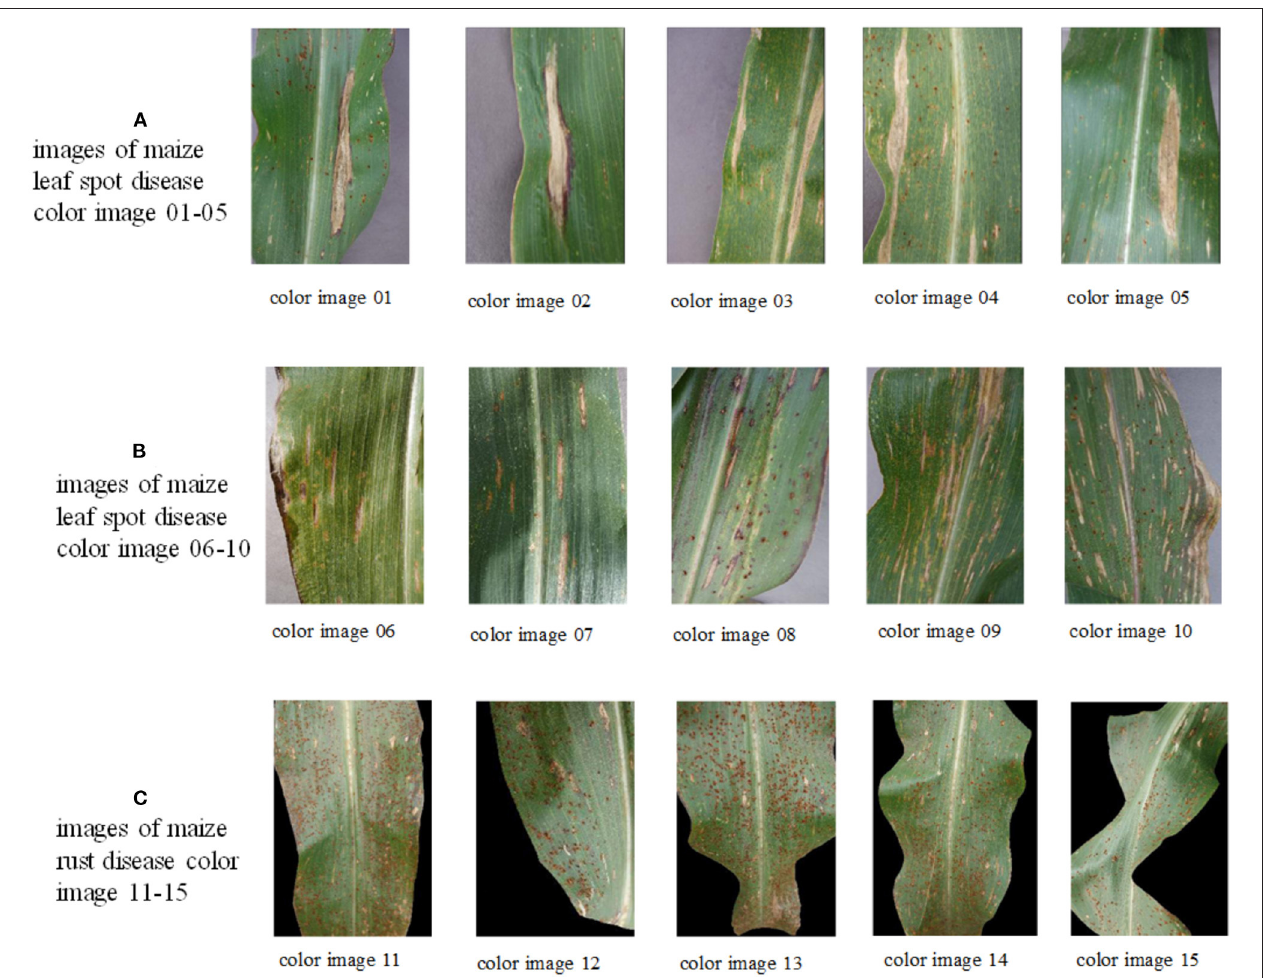
FIGURE 4 | Original images of maize leaf spot disease color images 1–5, maize gray spot disease color images 6–10, and maize rust disease color images 11–15 in the Plant